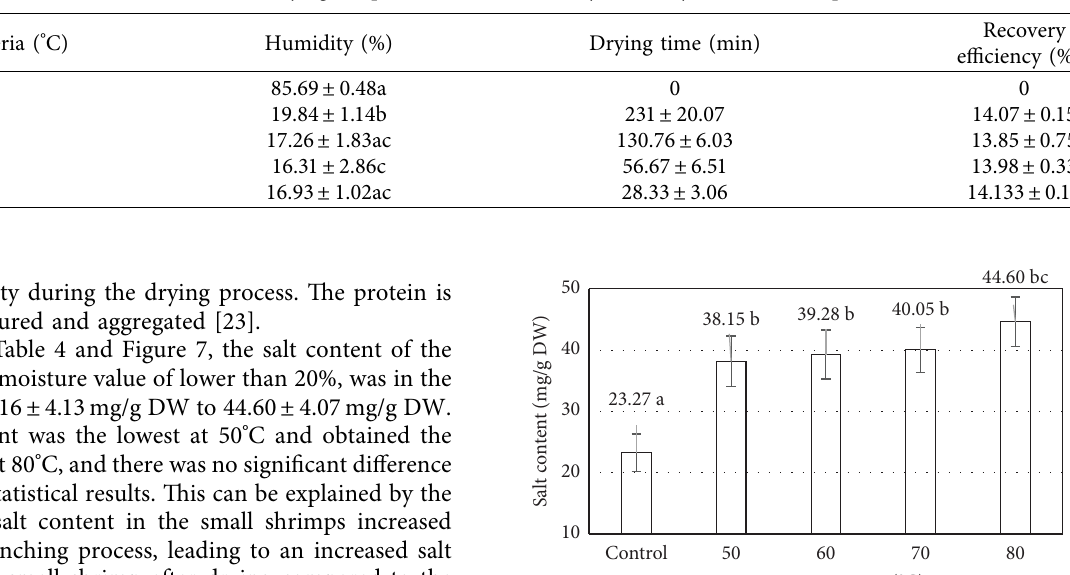
Figure 6: Efect of blanching time on astaxanthin content. Table 4: Efect of drying temperature on the recovery efciency of small shrimp.